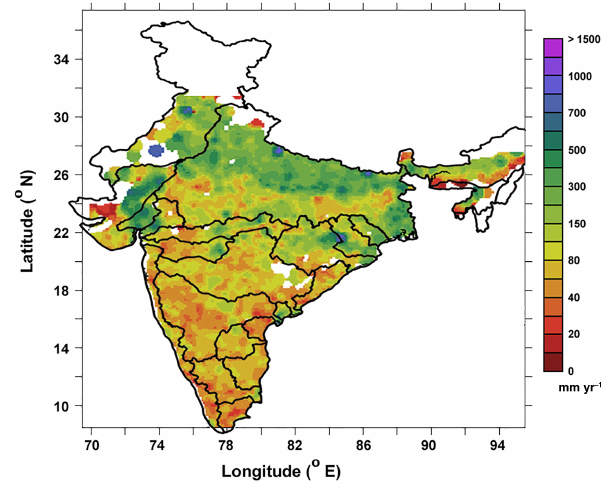
Figure 6. Map of mean recharge in the study period (1996–2015). Blank areas represent areas of no data availability.